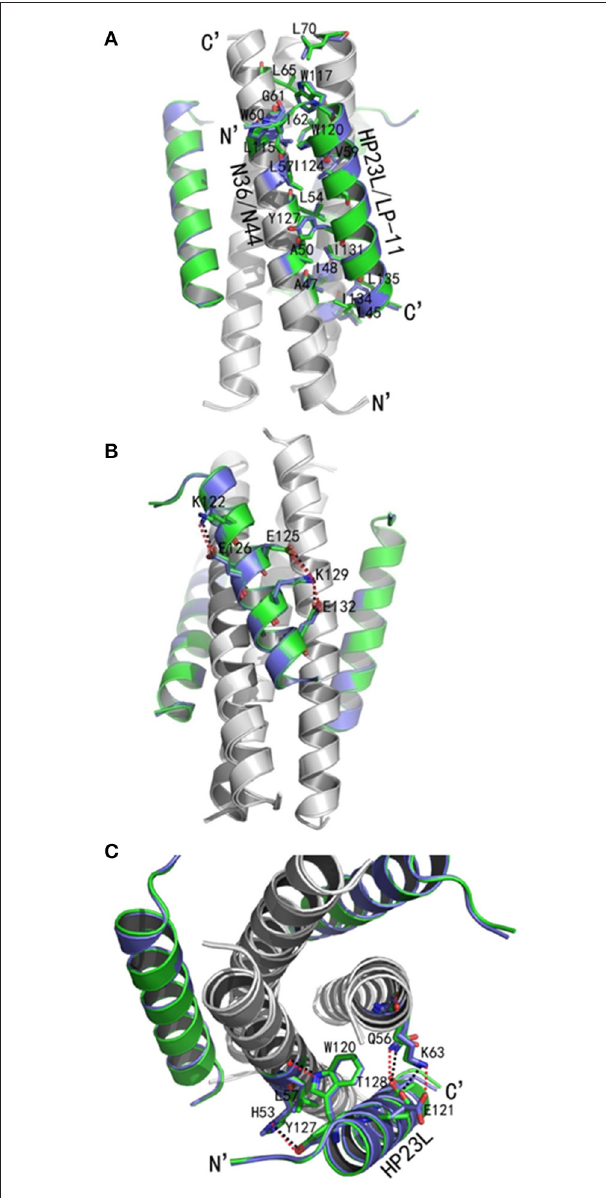
FIGURE 6 | Crystal structure of 6-HB formed by LP-11 and N44. (A) The structures of HP23L/N36 and LP-11/N44 are superimposed in ribbon models and compared for hydrophobic interactions. N44 and N36 trimers are shown in gray, HP23L and LP-11 are respectively shown in green and blue. Residues related to hydrophobic interactions of HP23L/N36 are shown as stick models and marked in green with labels, while the residues related to hydrophobic interactions of LP-11/N44 are shown as stick models and marked in blue with labels. (B) Superimposing comparison of the intrahelical salt-brides of HP23L and LP-11. NHR trimer is shown in gray; HP23L and LP-11 are respectively shown in green and blue. Residues involving in the formation of salt-bridges are shown as stick models with labels. Salt-bridges of HP23L and LP-11 are respectively indicated with dashed black and red lines. (C) Superimposing comparison of the interhelical salt-brides and hydrogen bonds of LP-11/N44 and HP23L/N36. NHR trimer is shown in gray. HP23L and LP-11 are respectively shown in green and blue. Residues involving in the salt-bridges and hydrogen bonds are shown as stick models with labels. Salt-bridges and